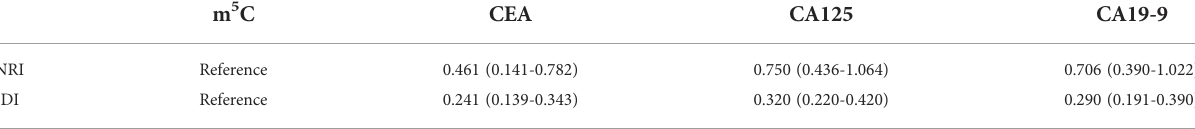
TABLE 3 NRI and IDI of m 5 C compared with other tumor